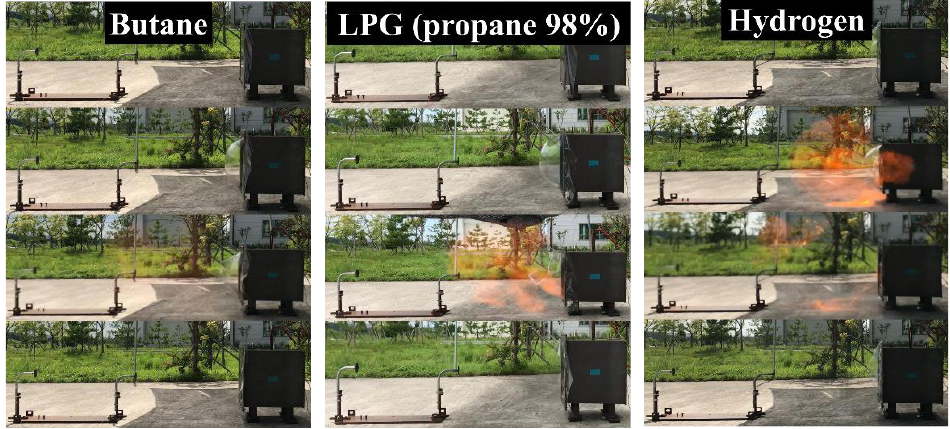
Figure 19. Explosion process in the square-type chamber.